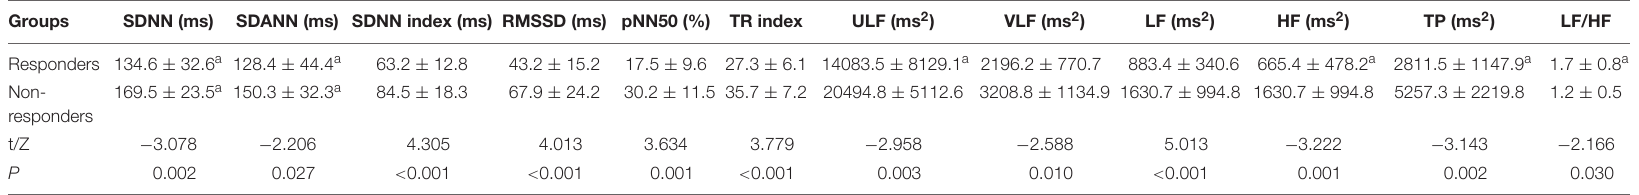
HRV, Heart rate variability; SDNN, standard deviation of all NN intervals during 24-h recording; SDANN, standard deviation of the average of NN intervals in all 5-min segments of the entire recording; SDNN index, mean of the standard deviation of NN intervals for each 5-min segment; RMSSD, root mean square of the successive NN interval difference; pNN50, percentage of adjacent RR intervals > 50 ms; TR index, triangular index; ULF, ultra low frequency; VLF, very low frequency; LF, low frequency; HF, high frequency; TP, total power; LF/HF, ratio of low to high frequency power. Data are mean ± SD. a Non-normal distribution.